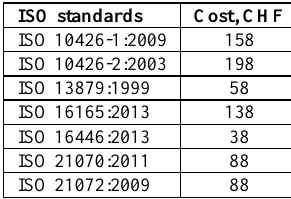
Table 2. Selective data on oil refining international standard prices